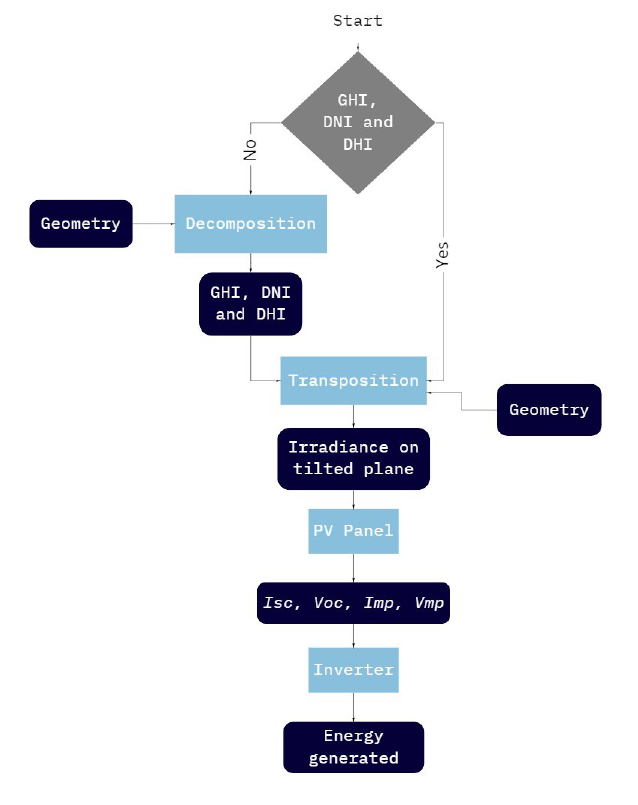
Figure 1. Simulation algorithm block diagram.